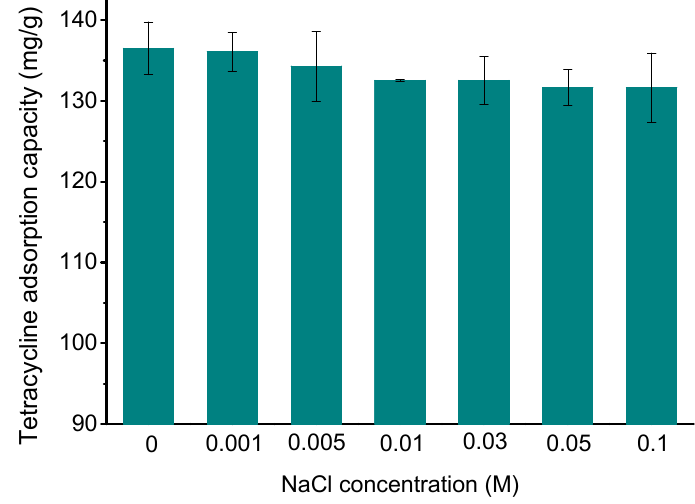
Figure 4. Effects of ionic strength on TC adsorption by Fe 3 O 4 @GO: pH = 4.0, m / V = 70 g/L, C 0(TC) = 10 mg/L, T = 303 K, t = 24 h.